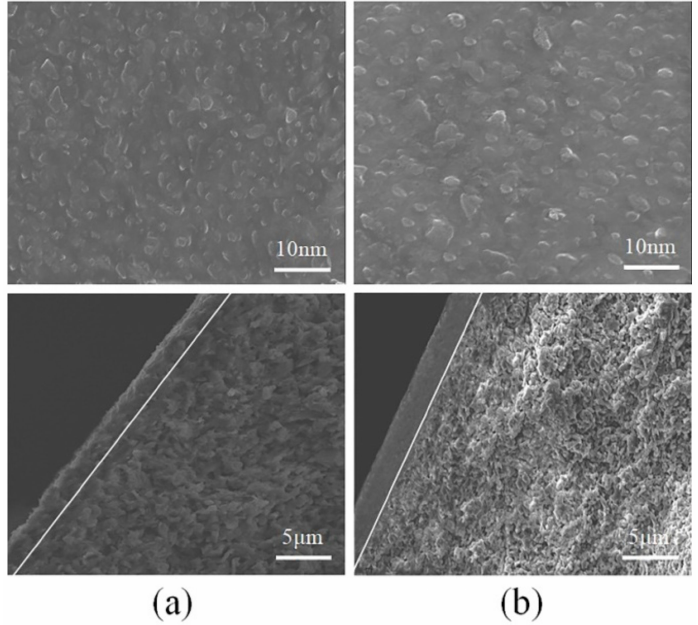
Figure 13. SEM images of membrane surface (top images) and cross-sections (bottom images) for sup- ported Co/MSiO 2 membranes with n Co = ( a ) 0 and ( b ) 0.08 calcined at 400 ◦ C under N 2